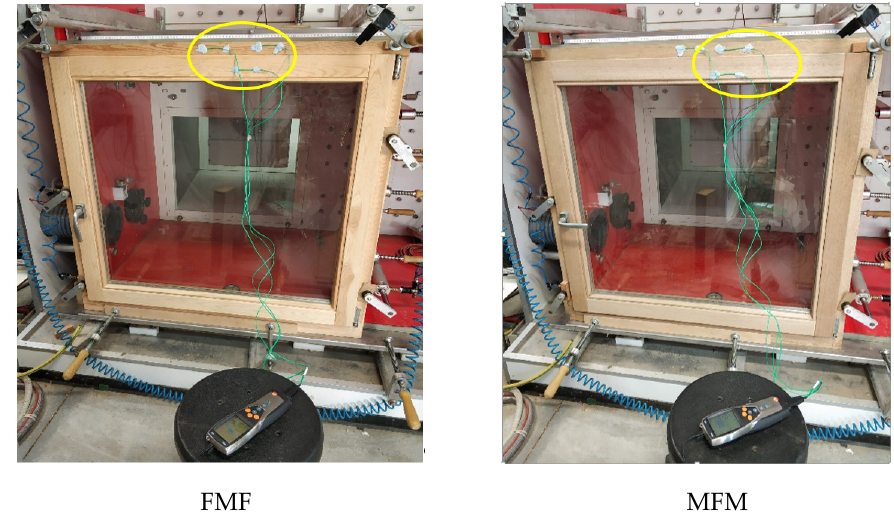
Figure 3. The HFM device with the attached thermocouples (green-cable edges at the yellow circle) taking reading for a 72 h period.